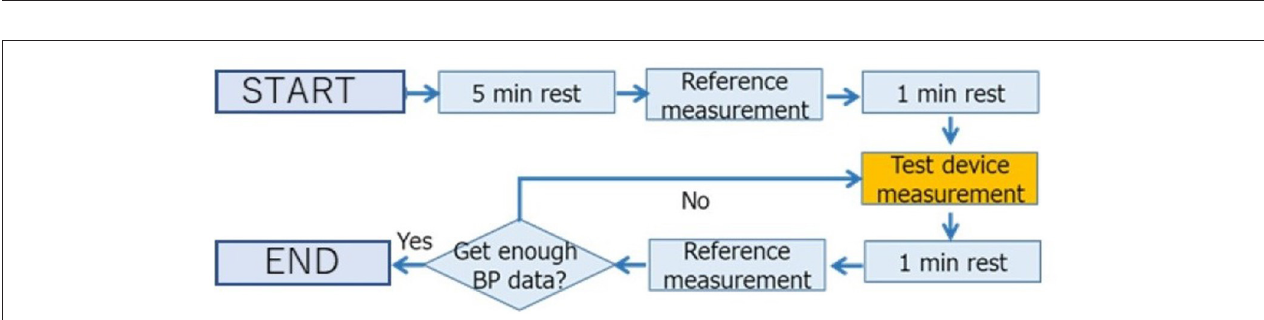
FIGURE 1 | Biopotential sensing system. (A) Biopotential amplification device and data transmitter, (B) First ECG electrical potential electrode, (C) Pulse wave sensor and the second ECG electrical electrode, (D) Receiving dongle, (E) Personal computer for data recording.